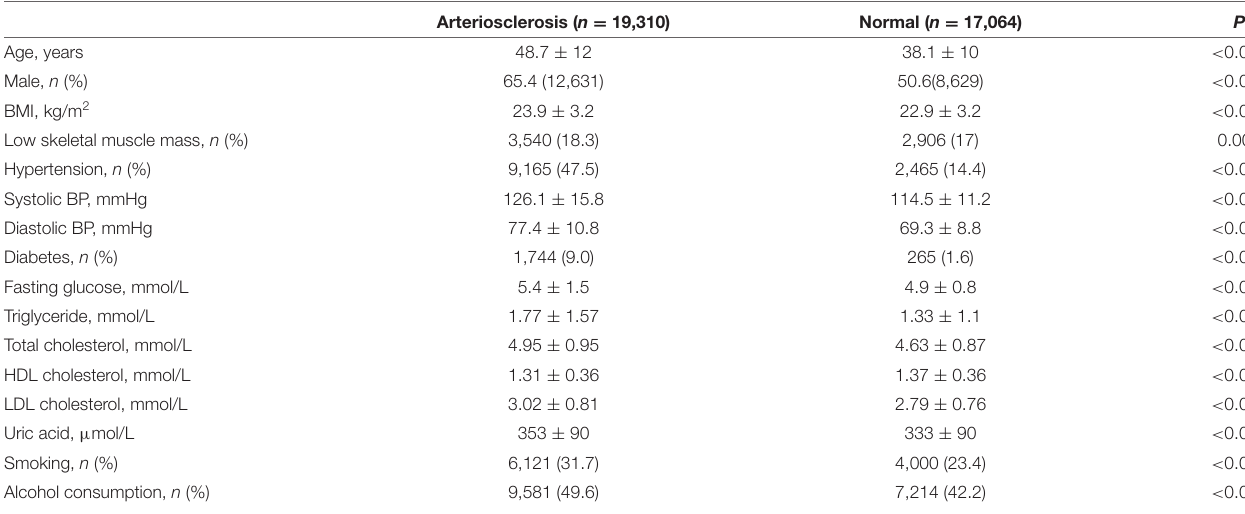
Arteriosclerosis ( n =